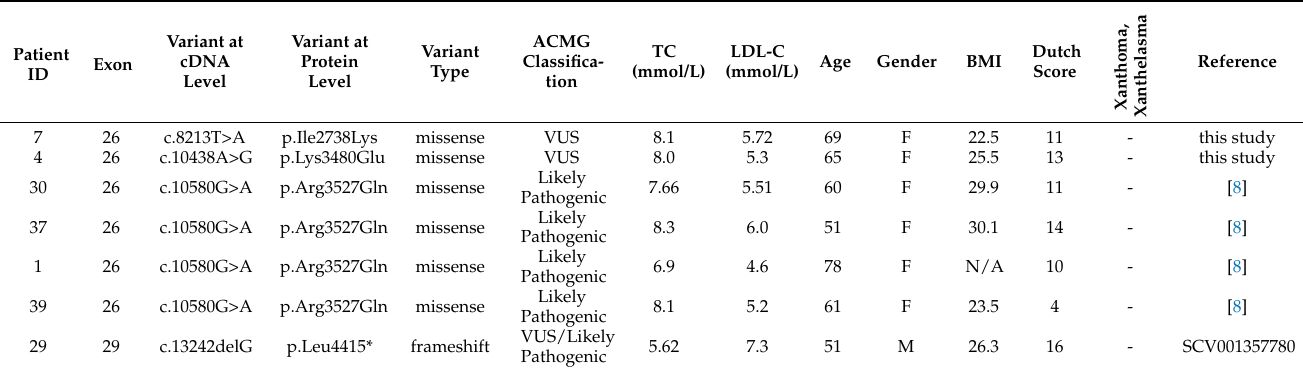
Table 1. Clinical and phenotypic data in Hungarian patients with APOB variants and detailed summary of APOB variants.